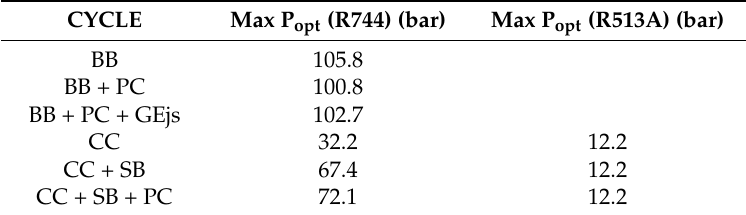
Table 4. Maximum optimum